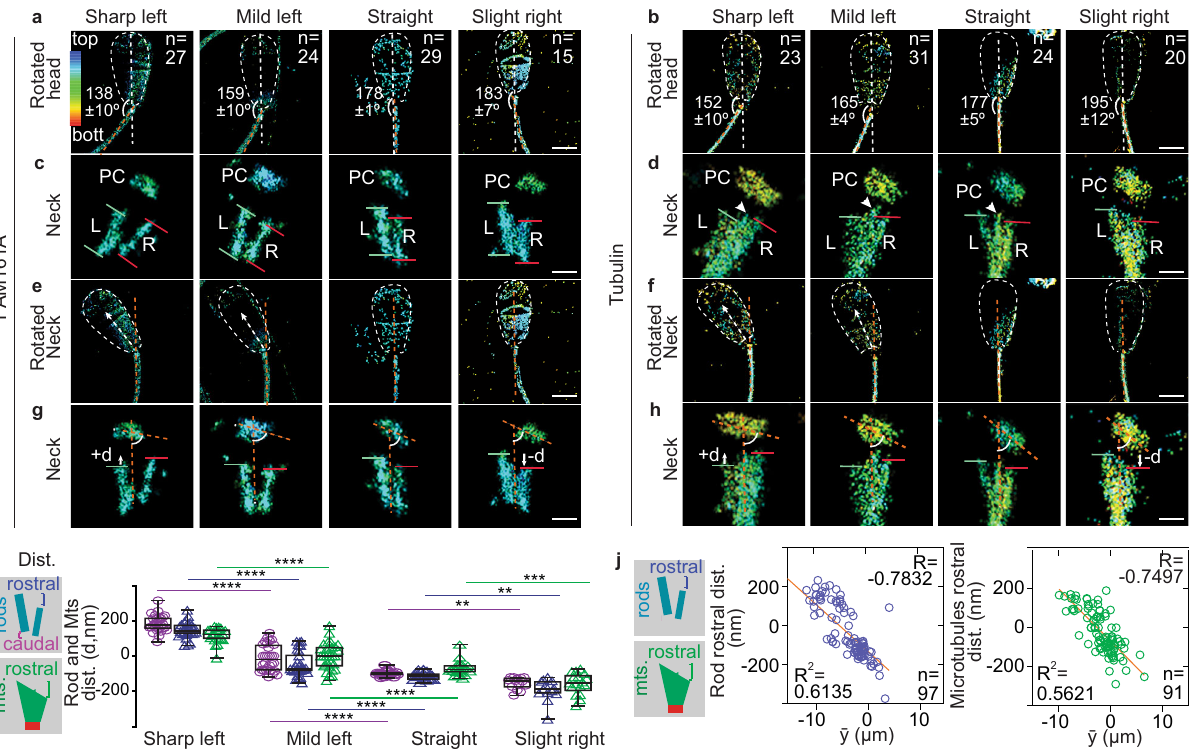
Fig. 3 The DC ’ s rods and lateral microtubules slide in correlation with tail beating. a , b The four types of sperm tail bending oriented according to centriole orientation-based sperm analysis (COSA). Chemically fi xed sperm were stained for either FAM161A ( a ) or tubulin ( b ). The white dotted line marks the head outline and midline, and the orange dotted line marks the neck midline. Head neck angles are shown as mean ± sd. c , d Zoom-in on the neck from panels a and b shows the location difference in the DC rod ( c ) and microtubule ( d ) edges. Arrowhead marks the central microtubules ( d ). Lines mark the left (L, green) and right (R, red) sides edges of each substructure. e , f STORM images rotated to orient the neck midline vertically. The white arrow shows how the head bends to the left during tail beating to the left. g , h Zoom-in on the neck from the panels ( e ) and ( f ). The orange dotted lines mark the midlines of the neck/DC. We de fi ne d as the distance between the rods and microtubules on the right side of the DC relative to those on the left side. Note that d is positive ( + d) when the right side is higher than the left and negative ( − d ) when the right side is lower than the left. i Rostral (purple) and caudal (magenta) DC rod distance (dist.) and rostral DC microtubule distance (green) during the tail beating. The schematic on the left side of each graph represents the measurement scheme shown in the y -axis of the graph. Data are presented as box and whisker plots, where upper and lower bounds show interquartile range, line within the box shows median, and whiskers show minimum and maximum data points. All experiments were repeated three times independently with similar results. Statistical analyses used are an unpaired, two-tailed t test.**** p < 0.0001, *** p < 0.001, ** p < 0.01. j Correlation analysis between DC sliding at the rostral end (Y-axis) and tail beating amplitude ( (cid:1) y ) ( x -axis). The solid orange line in scatters plots represents the regression line. Every data point represents a cell. R Pearson correlation, R 2 linear regression. Correlation is statistically signi fi cant ( P < 0.0001). Scale bars, 250 nm. Source data are provided as Source Data